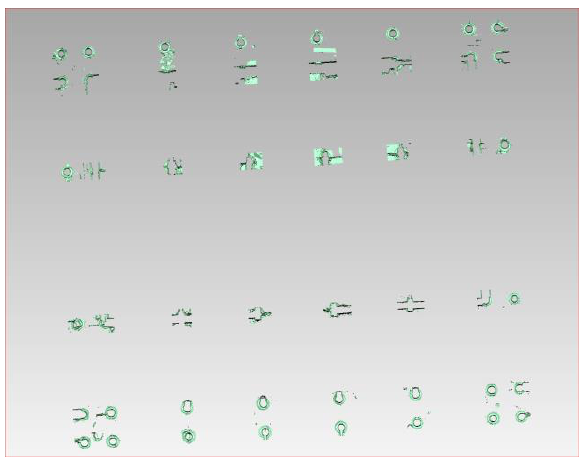
Figure 11. Columns of the Main Hall of Jingfu Palace, Forbidden City (the Place Museum), Beijing, point cloud segment